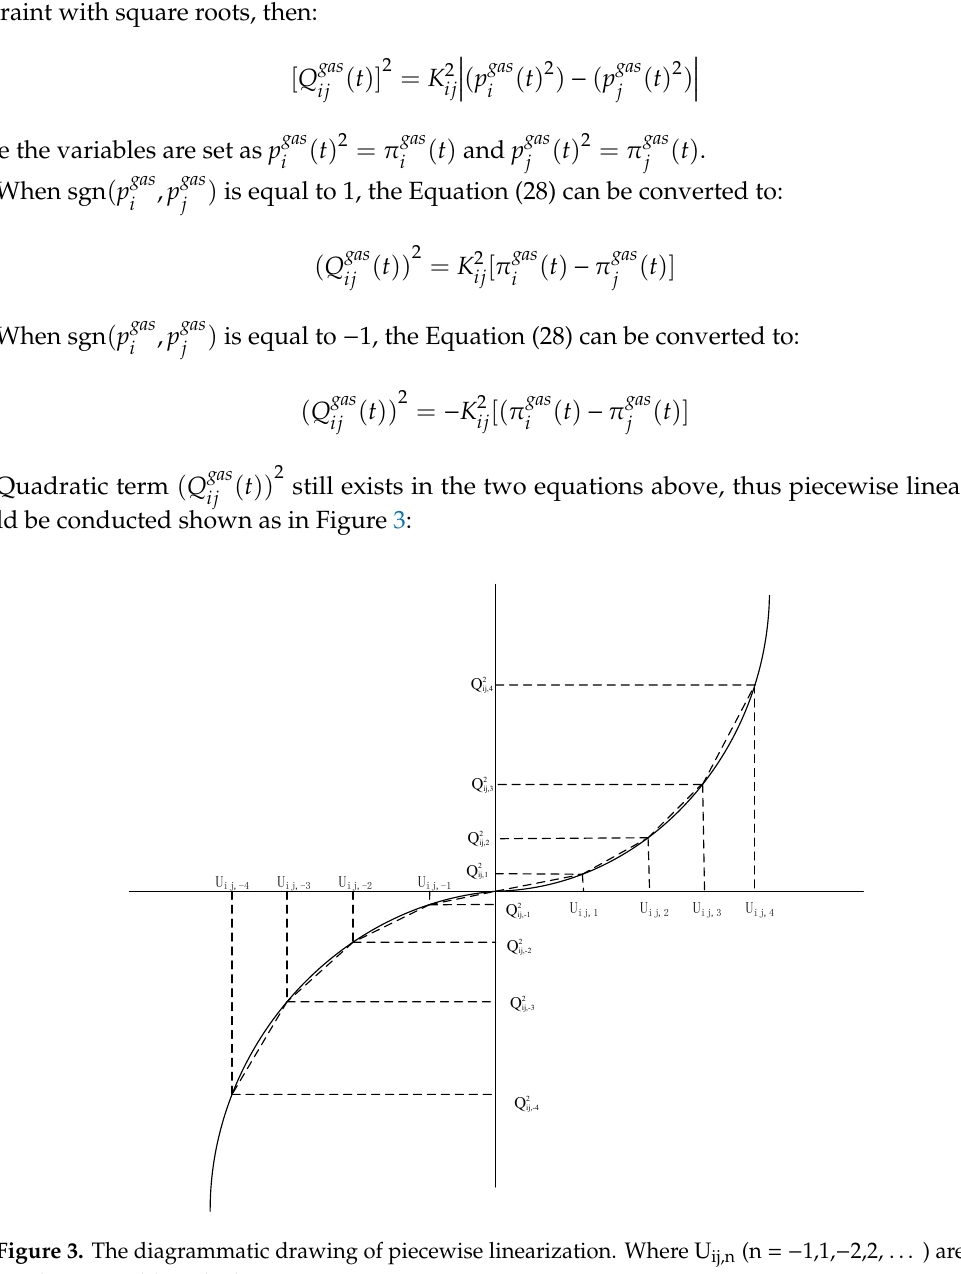
= − 1,1, − 2,2, ... ) are all ij,n (n